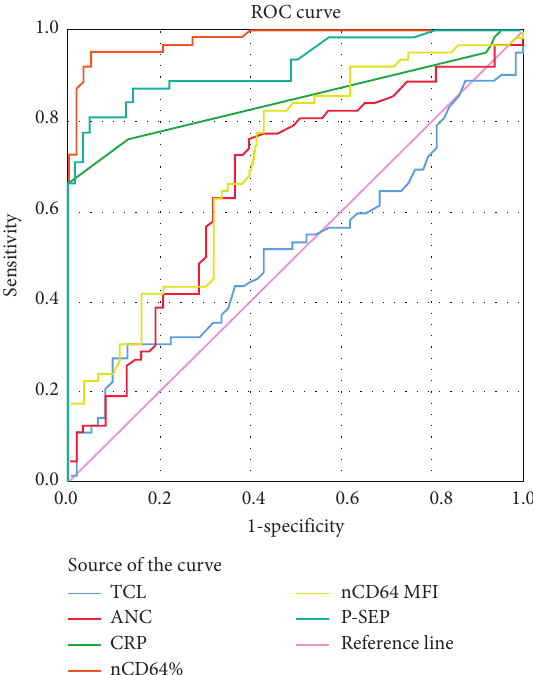
Figure 3: ROC curve analysis showing the diagnostic performance of studied biomarkers for the discrimination between sepsis pa- tients and the control groups. Table 6: Multiregression analysis (final model). Model 3 Reg. coef. Sig.